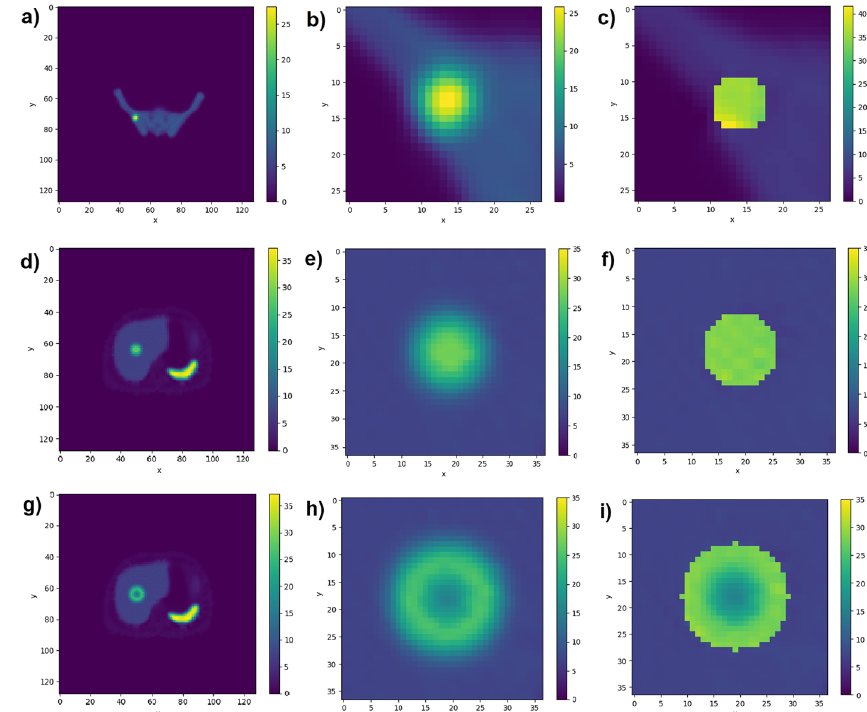
Fig. 9 Noise‑free images, in the transaxial plane, of the anthropomorphic phantom datasets. From left to right these show; uncorrected images reconstructed with 200 updates, the local region around the lesion in the uncorrected image, and post‑PVC images after correction with 10 STC iterations. a – c The pelvis region of the bone scan phantom. d – f A uniform lesion in the liver of the Tektrotyd phantom. g – i The non‑uniform lesion in the liver of the Tektrotyd